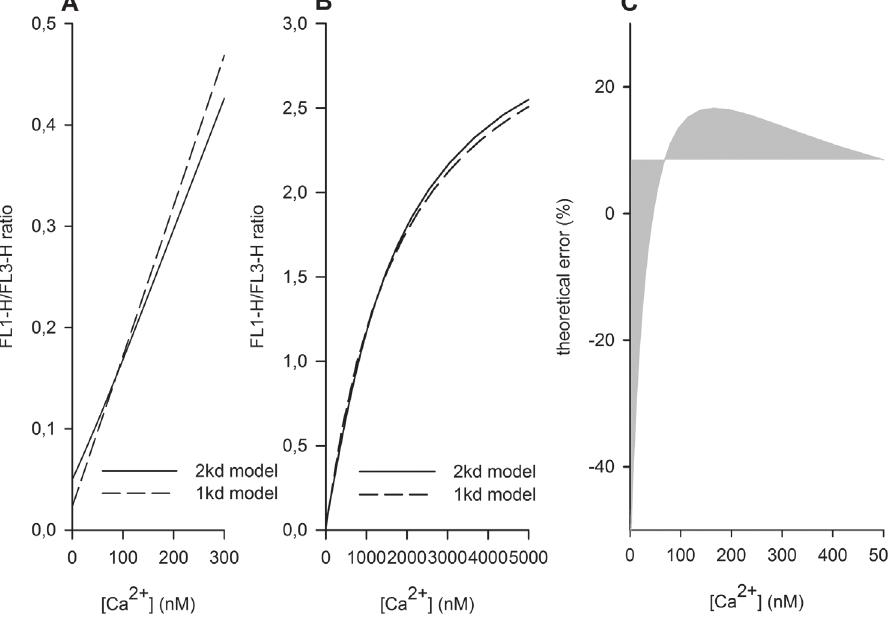
Fig 2. Fluo4/Fura Red ratios calculated by different kd models. Differences between the “ one kd ” model (Equation 4) and the “ double kd model ” (Equation 9) for low (A) and high (B) Ca 2+ concentrations are shown. (C) Theoretical error between the two models is depicted. Both models were fitted by non-linear regression (least squares).